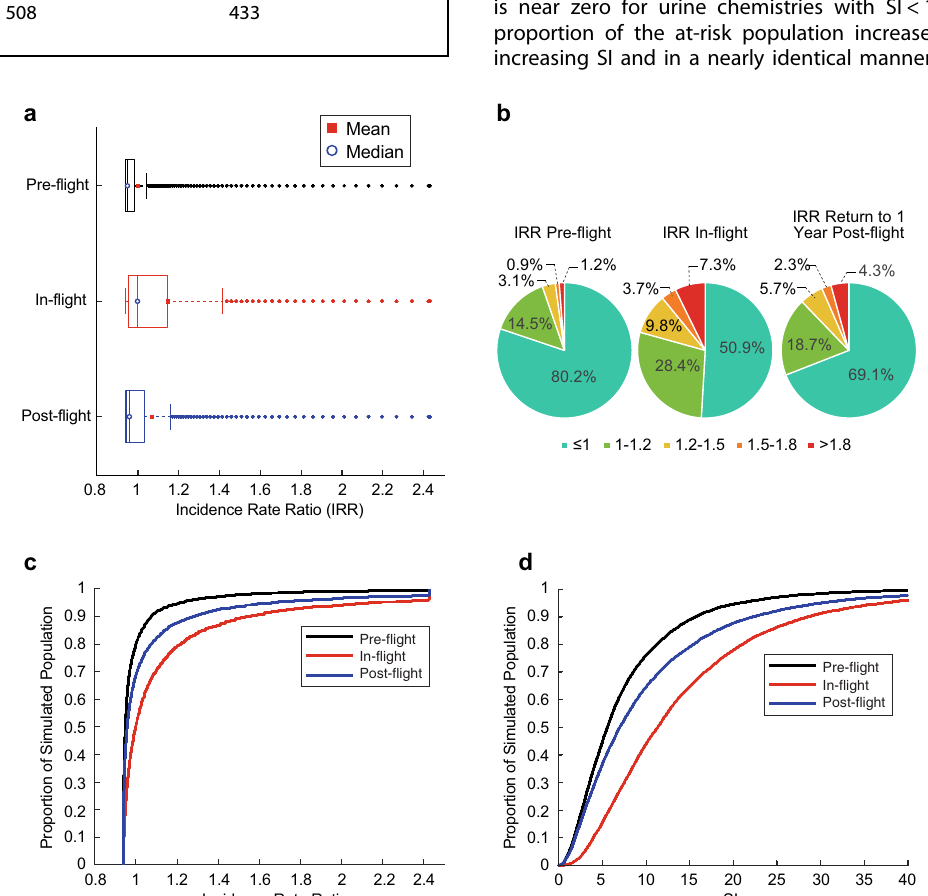
Fig. 4 IRR distribution of the modeled astronaut population per fl ight phase. The predicted variation in renal stone risk for each simulated fl ight phase is shown following the renal stone risk analysis process described in the “ Methods ” section with a IRR distributions represented as box plots, b pie charts of the percentage of the simulated astronaut populations at select IRR intervals c cumulative density graphs of IRR, and d cumulative density graphs of SI for the simulated astronaut population. The estimated IR data is normalized to IRR using the predicted mean pre- fl ight incidence rate. We chose the IRR ranges in c to correspond to relatively important IRR ranges identi fi ed in the referent analysis or where natural cutoffs existed in the data